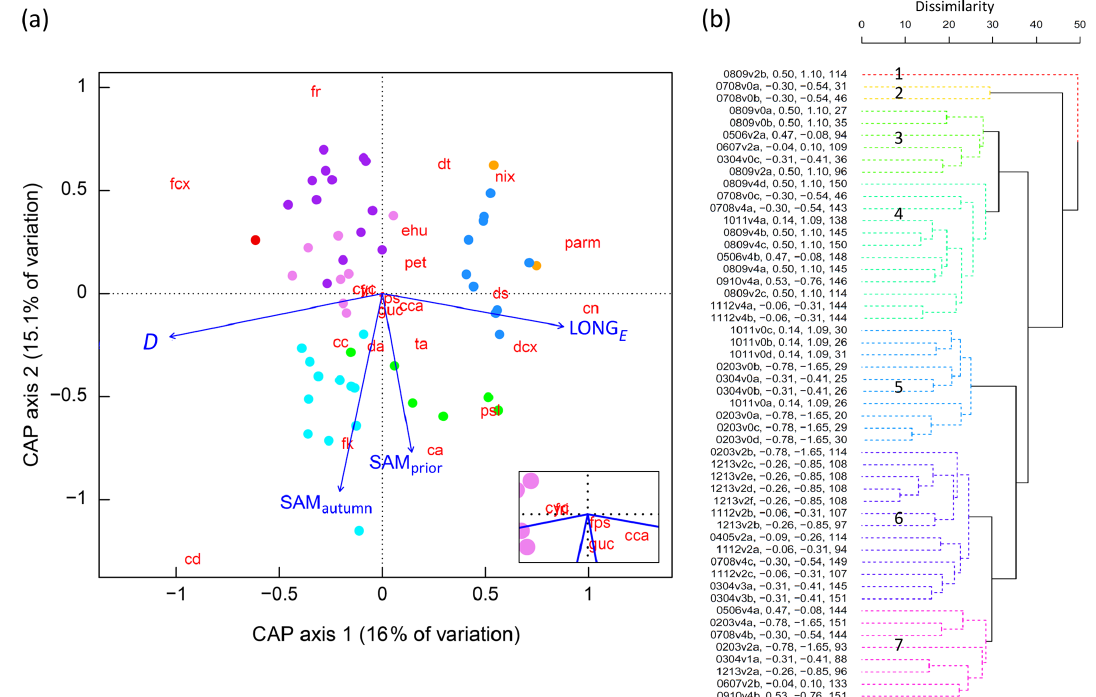
Figure 6. (a) CAP analysis of phytoplankton community composition. Dots represent individual samples, with colours corresponding to significant clusters (Fig. 6b). The 22 phytoplankton taxa/groups are overlain as weighted averages of their sample scores (red abbreviations, after Fig. 2) with positions plotted with a 3-times-larger distance from the origin to more easily visualise their relationships with constraining environmental variables. Linear projections of the significant constraining environmental covariates appear as blue arrows, the length and angle of which represent the magnitude and direction of influence of each variable on community composition. The inset shows the taxa located close to the origin, diatoms fri and cyc collocating. (b) Cluster analysis dendrogram of the 52 samples based on similarities in phytoplankton community structure, using colour to show seven significantly different groups (numbered 1–7, solid lines, α = 0 . 05). Sample labels contain season and voyage (e.g. 0809v2b = austral spring–summer over 2008–2009, voyage designation 2 , sample b is the second sample obtained from the SIZ during that voyage), SAM autumn value, SAM prior value, and the D